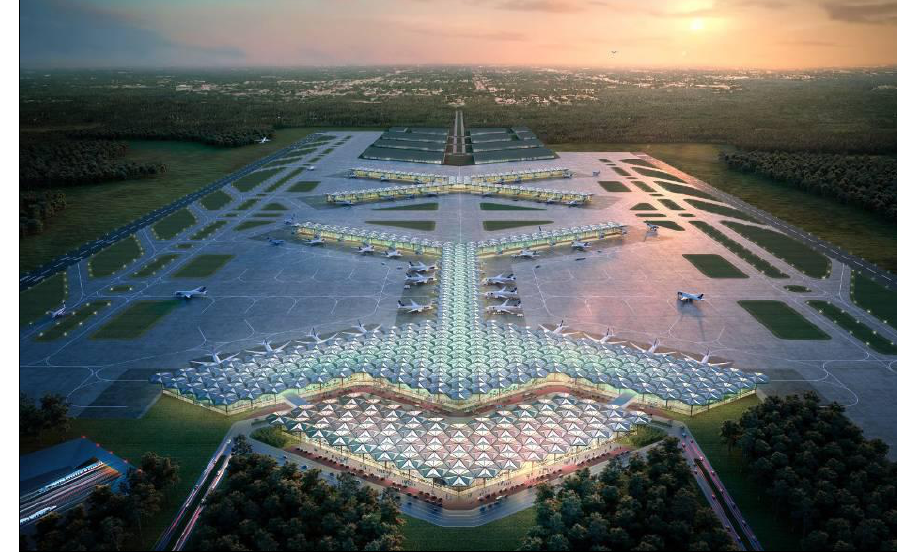
Figure 2. The SHT concept by Forter + Partners [92].